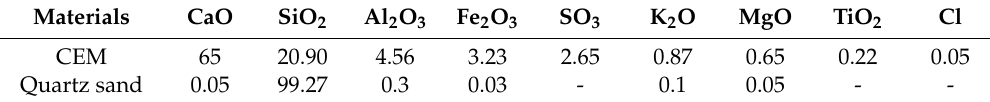
Table 2. Mix proportion of cement-based healing pellets